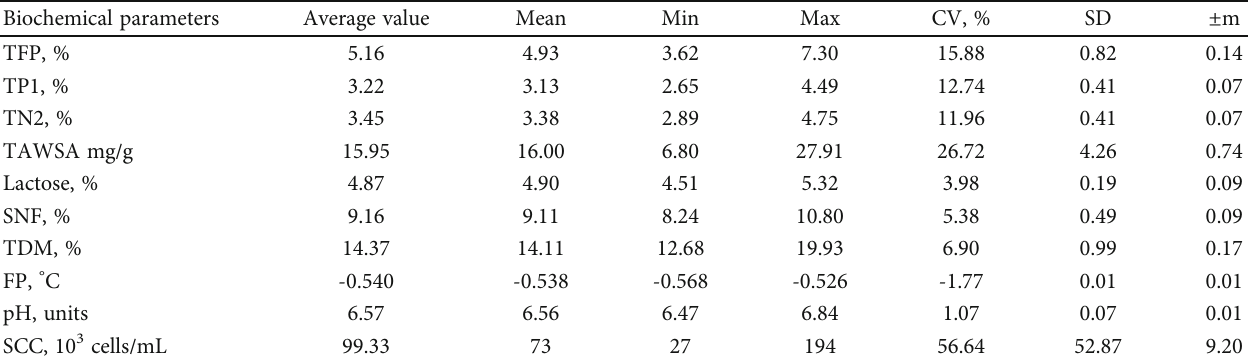
Table 1: The major biochemical parameters and component composition of milk samples ( n = 33 , group 1). Biochemical parameters